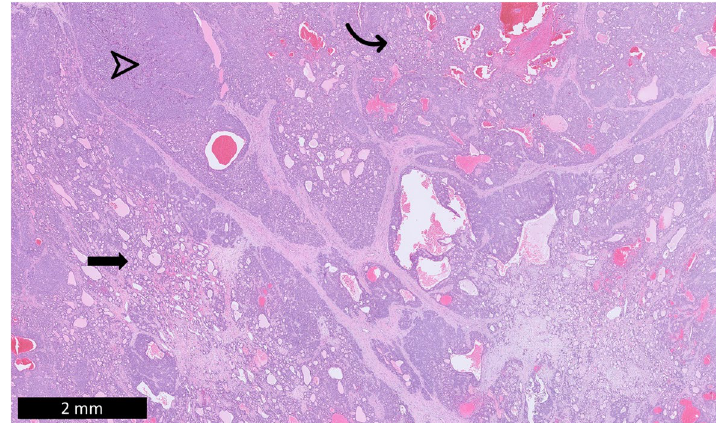
Fig. 2 The mass demonstrates multiple histologic patterns including tubuloglandular structures (curved arrow), solid sheets and trabeculae (arrowhead), and small spaces lined by biliary-like epithelium and filled with eosinophilic proteinaceous luminal material (arrow).